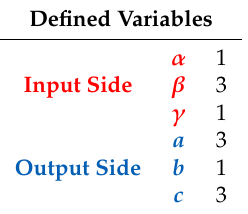
Table 4. Values for the six parameters for a three-module Input-Series Output-Parallel (ISOP) power